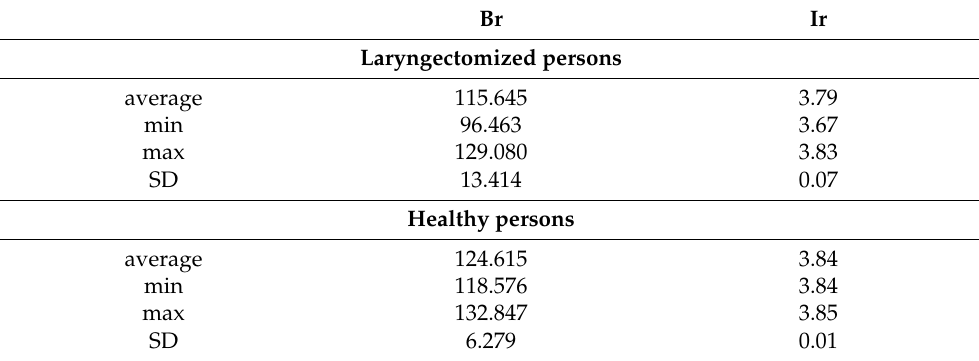
Table 8. The first phonetic segments „pa”—descriptor values—the word